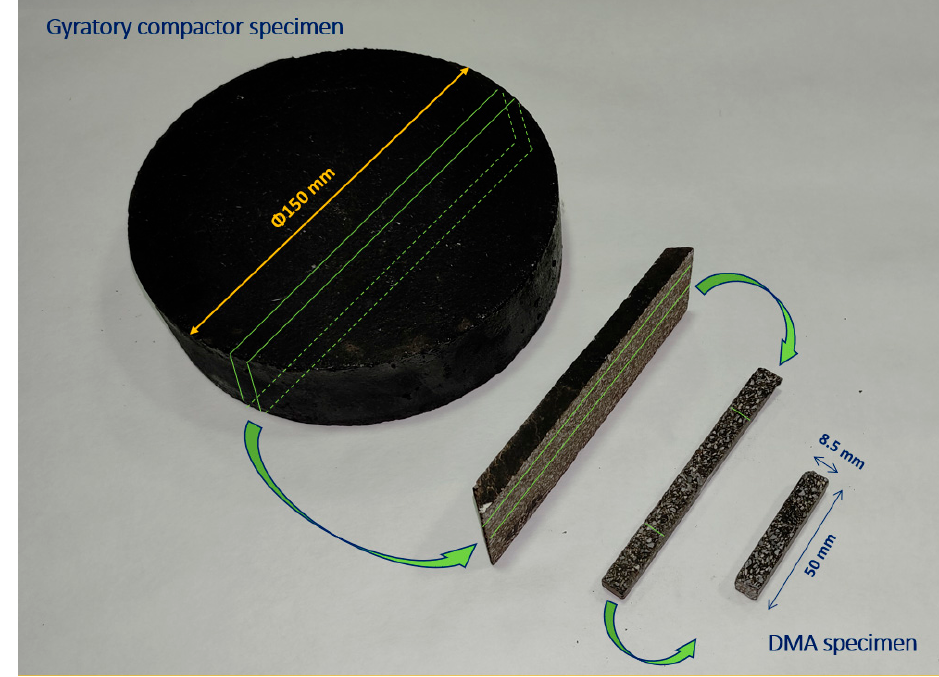
Figure 2. Obtaining process of the mortar samples used in DMA tests. Table 5. Density of the asphalt mortars tested.